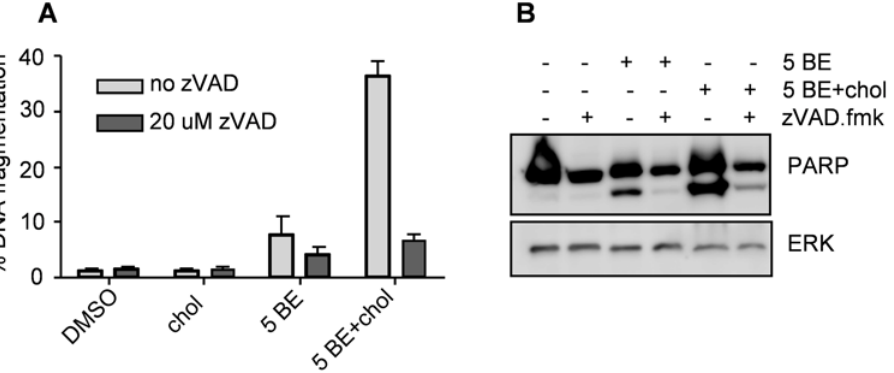
Figure 2. BE/cholesterol induces apoptosis in Jurkat cells. (A) Jurkat cells were pretreated with 20 m M zVAD.fmk for at least one hour prior to addition of either DMSO, 5 m M cholesterol (5 Chol), 5 m g/ml BE (5 BE) or 5 m g/ml BE in combination with 5 m M cholesterol (5 BE + chol). After 24 hours DNA fragmentation was assessed by FACS analysis of propidium iodide (PI) stained nuclei. (B) Jurkat cells were treated as described in (A) but after 24 hours PARP cleavage was assessed by immunoblotting. The protein kinase ERK was used as a loading control.